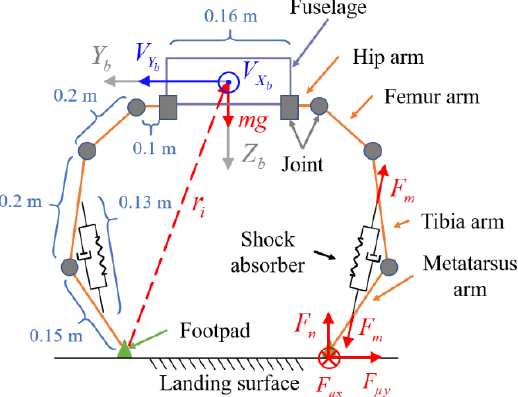
Figure 3. Diagram of aircraft component dimensions and vectors in Equations (1)–(4). The force vectors are shown in red, velocity vectors are shown in blue, and body axes are shown in gray.